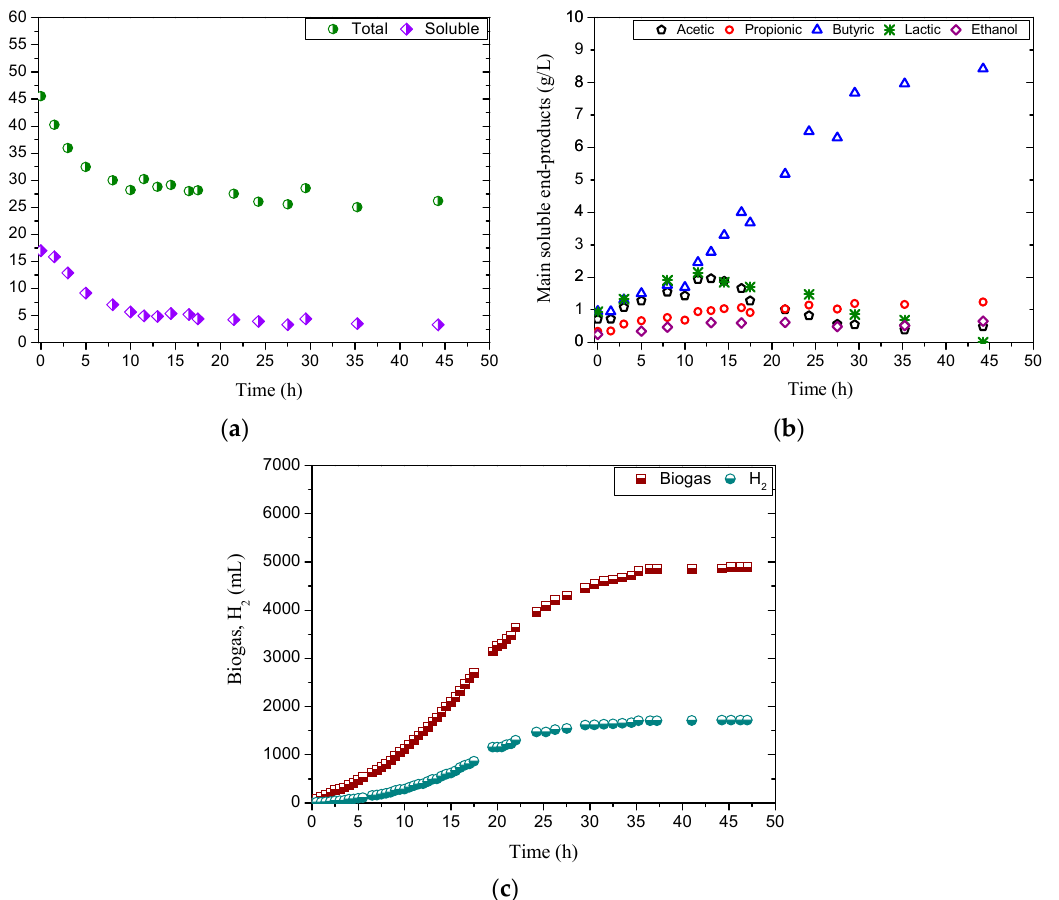
Figure 2. ( a ) Consumption of carbohydrates, ( b ) evolution of VFAs, lactic acid and ethanol, and ( c ) gaseous products (biogas and hydrogen) during batch acidogenesis of mixture (95% FS and 5%LCM), at pH 5.0.